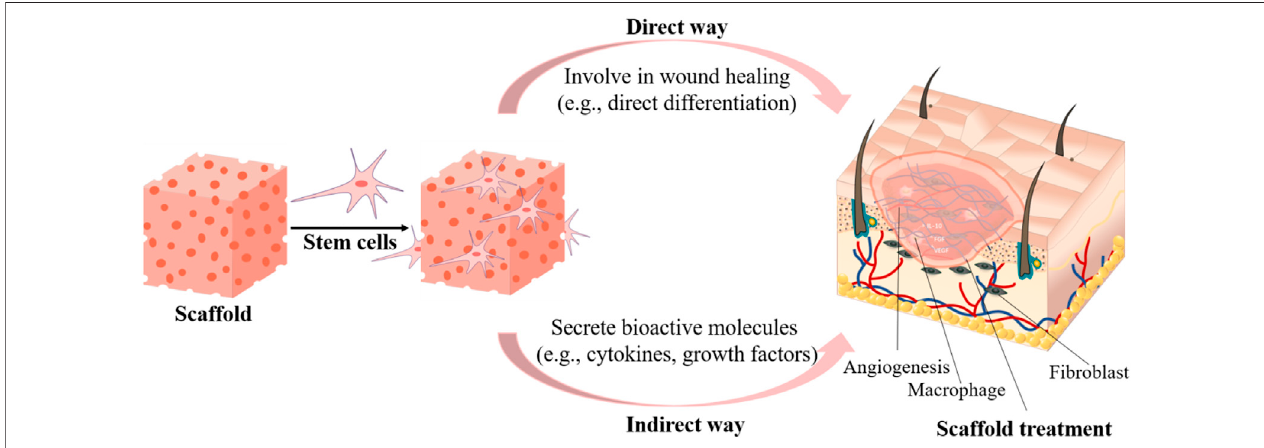
FIGURE 3 | Encapsulating stem cells into scaffolds to enhance wound healing either through contributing to new tissue formation or by releasing regulating